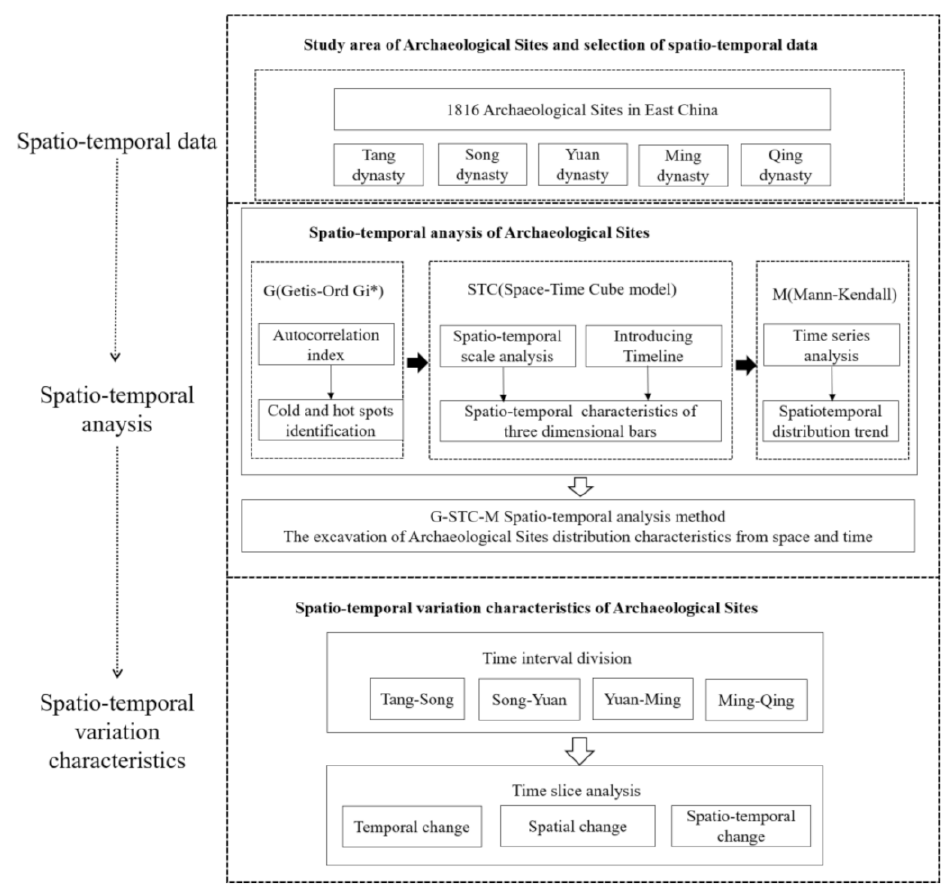
Figure 6. Technical flow